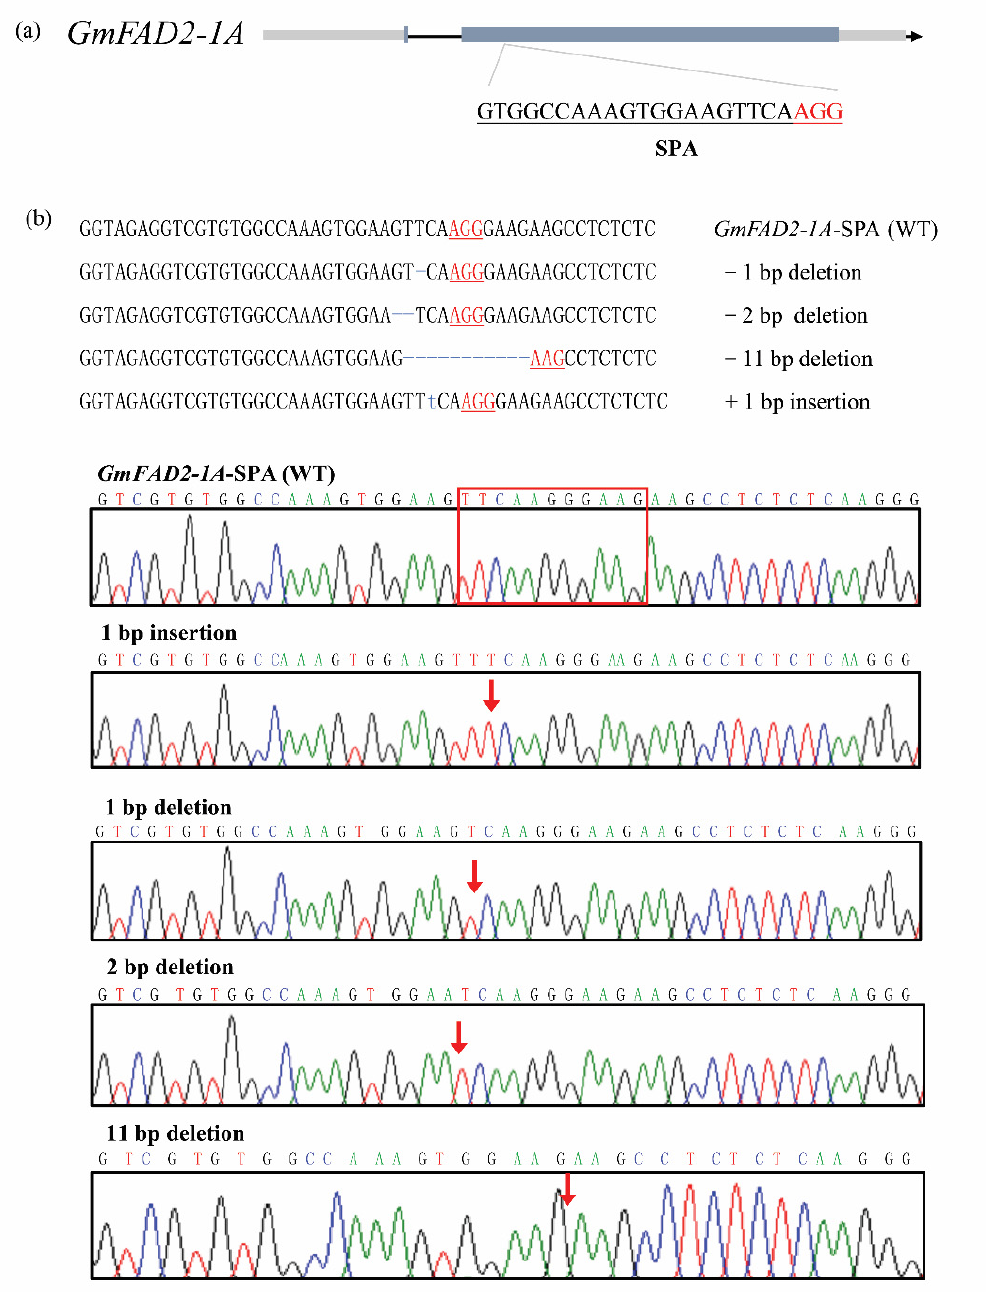
Figure 1. Homozygous targeted mutagenesis of GmFAD2-1A induced by CRISPR/Cas9. ( a ) Gene structures of GmFAD2-1A with target sites of CRISPR/Cas9. Black solid line: intron; blue stripe: CDS; gray stripe: UTR (untranslated region). ( b ) Sequencing of the mutants. Deletions and insertions are indicated as dashes and blue lowercase letters, respectively. The PAM is in red uppercase letters. The types of indels (insertions–deletions) are indicated in the right